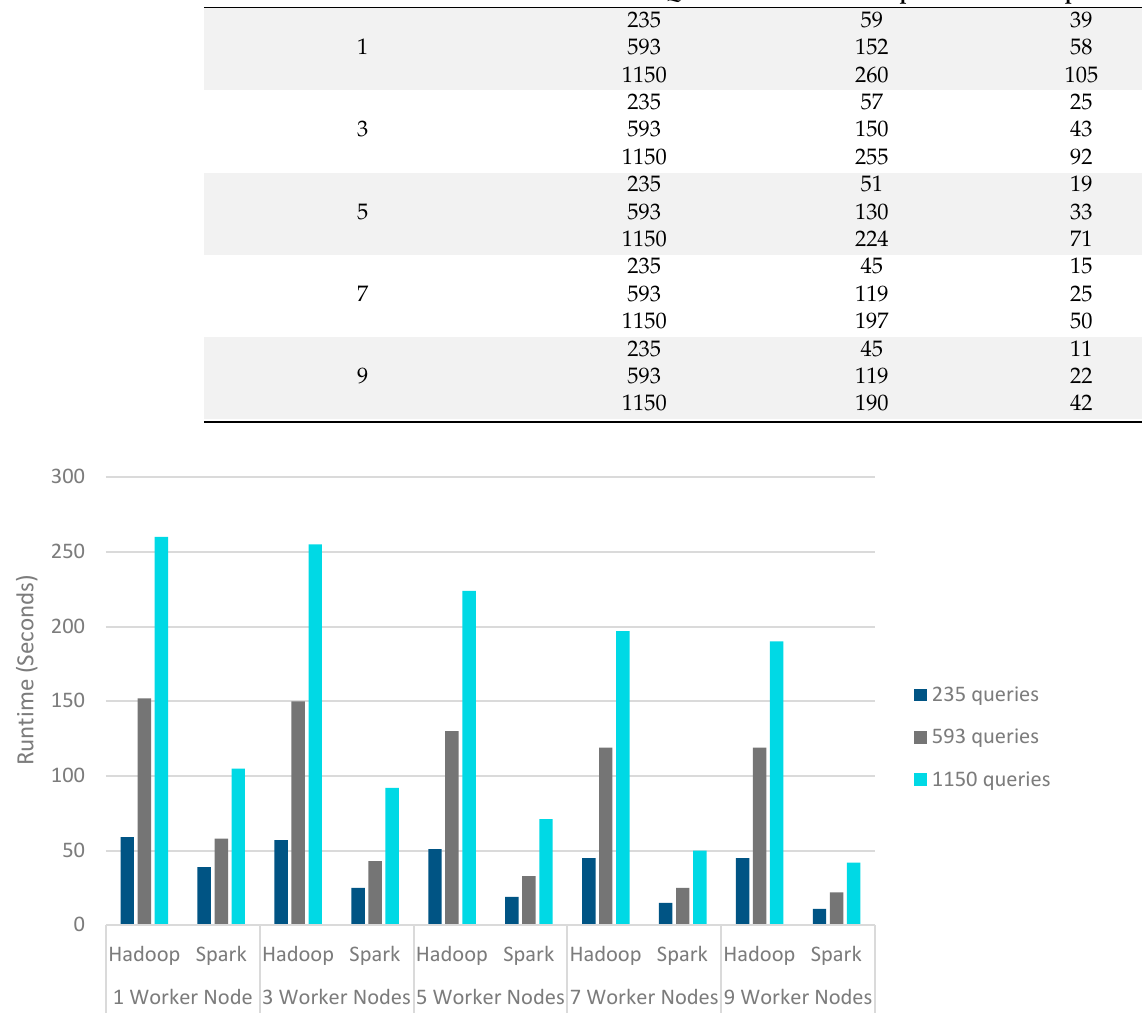
Table 4. Run-time (Seconds) of Hadoop and Spark with the change in number of queries. Number of Worker Nodes